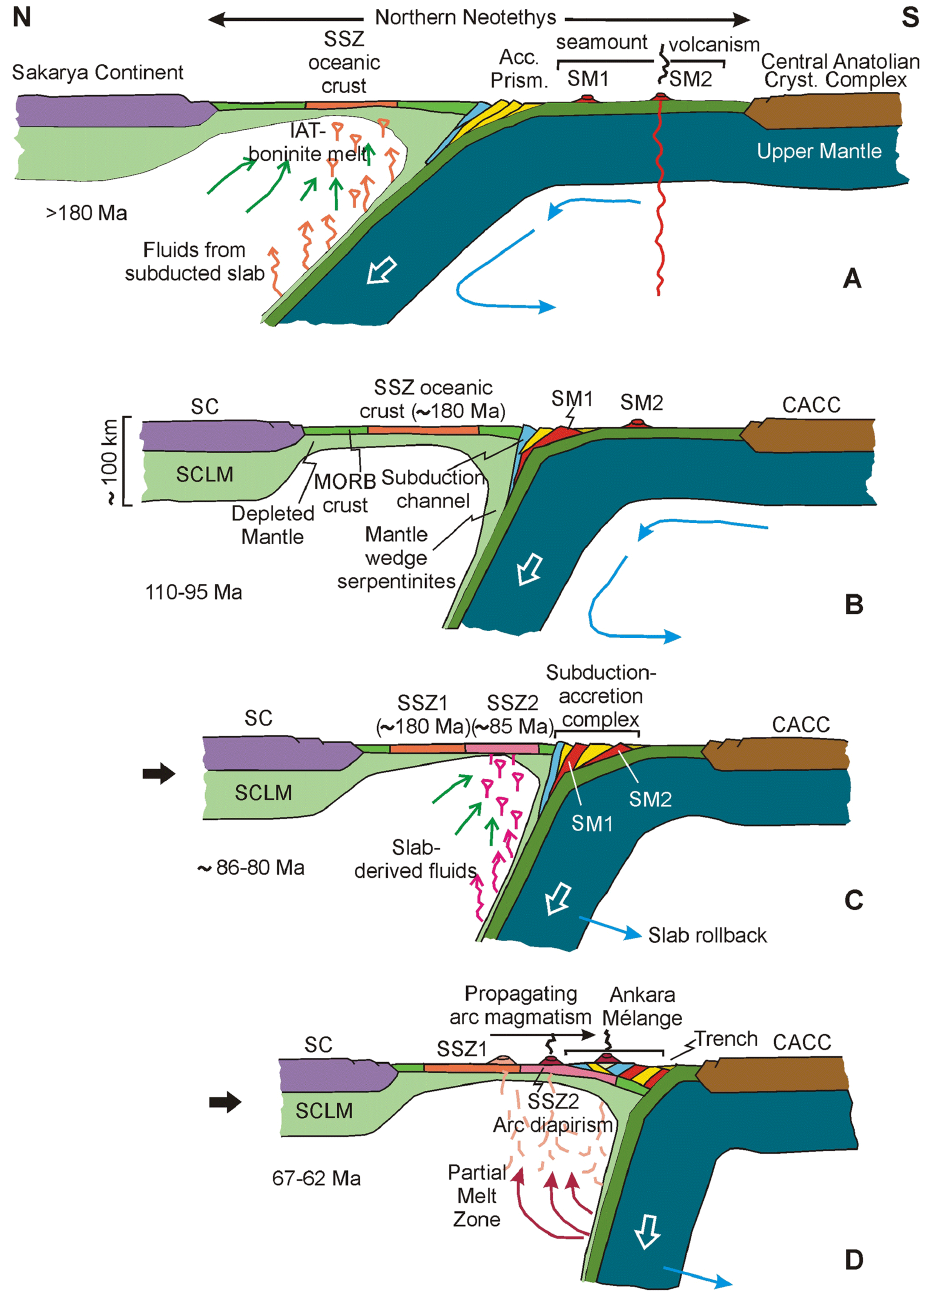
Fig. 20. Sequential tectonic diagrams depicting the intraoceanic magmatic evolution of the Ankara Mélange in the northern Neotethys during the Jurassic through Paleocene. (A) Suprasubduction zone generation of the oldest Neotethyan oceanic crust ( ∼ 180Ma) in the upper plate of a north-dipping intraoceanic subduction zone, and seamount construction (SM1 and SM2) in the down-going oceanic plate. High-grade metamorphic rock blocks and turbiditic sandstone–mudstone sequences in the Ankara Mélange formed in the subduction channel (blue) and then the accretionary prism formed. (B) Accretion of seamount-1 (SM1) into the accretionary complex and related deformation in the subduction–accretion system. (C) Slab rollback and associated extension and SSZ oceanic crust formation ( ∼ 85–80Ma) in the upper plate, accretion of seamount-2 (SM2) into the accretionary complex, and the lateral growth and deformation in the subduction–accretion system. (D) Island arc construction and magmatism on and across the preexisting SSZ oceanic lithosphere and the subduction–accretion complex (i.e., Ankara Mélange units). With continued slab retreat, arc magmatism shifts southward, following the migrating trench, and becomes more alkaline in time, producing lamprophyric and syenodioritic intrusions. See text for further explanation.